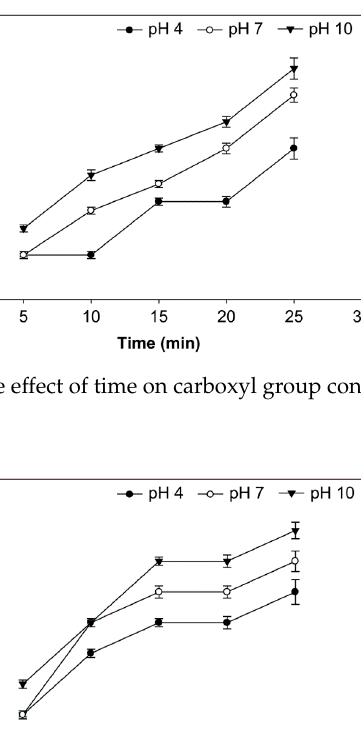
Figure 4. The effect of time on carboxyl group content at various pH with the starch concentration of 10% ( v / w ).